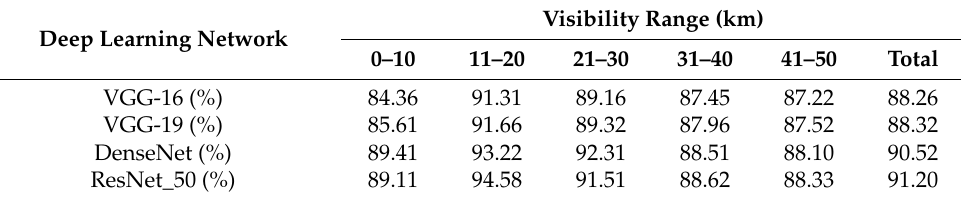
Table 6. Visibility accuracy of different